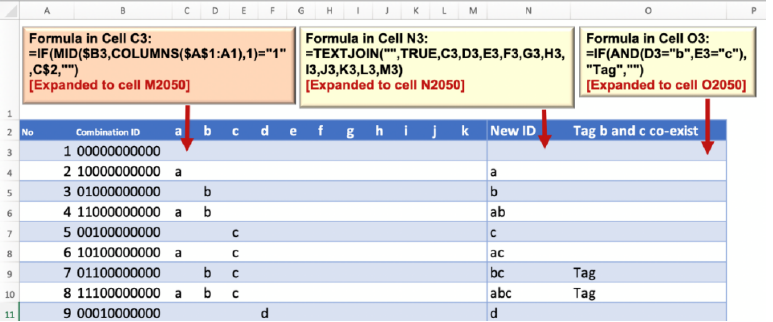
Figure 2. Determining and proving 2048 unique combinations of 11 predictors .